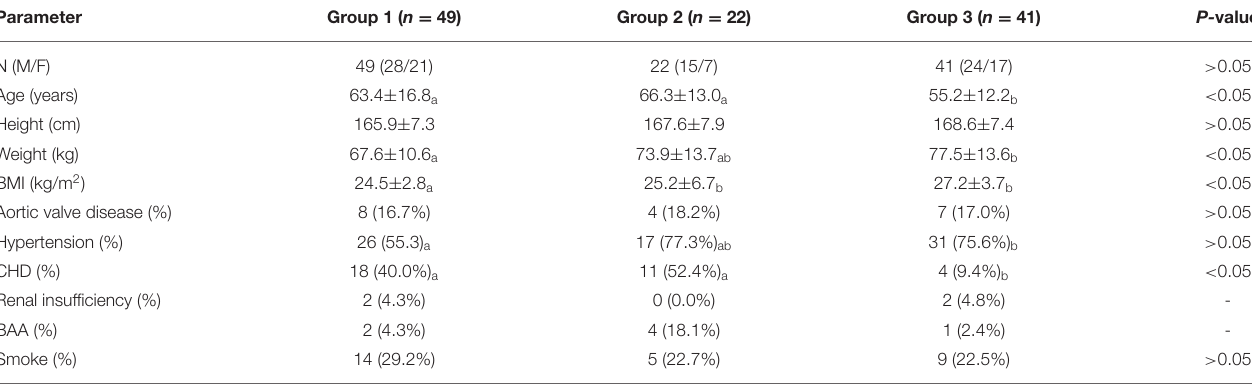
TABLE 1 | Clinical